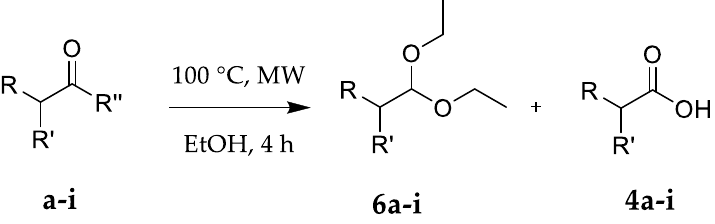
Table 10. Reactions with different carbonyl compounds using ethanol as solvent